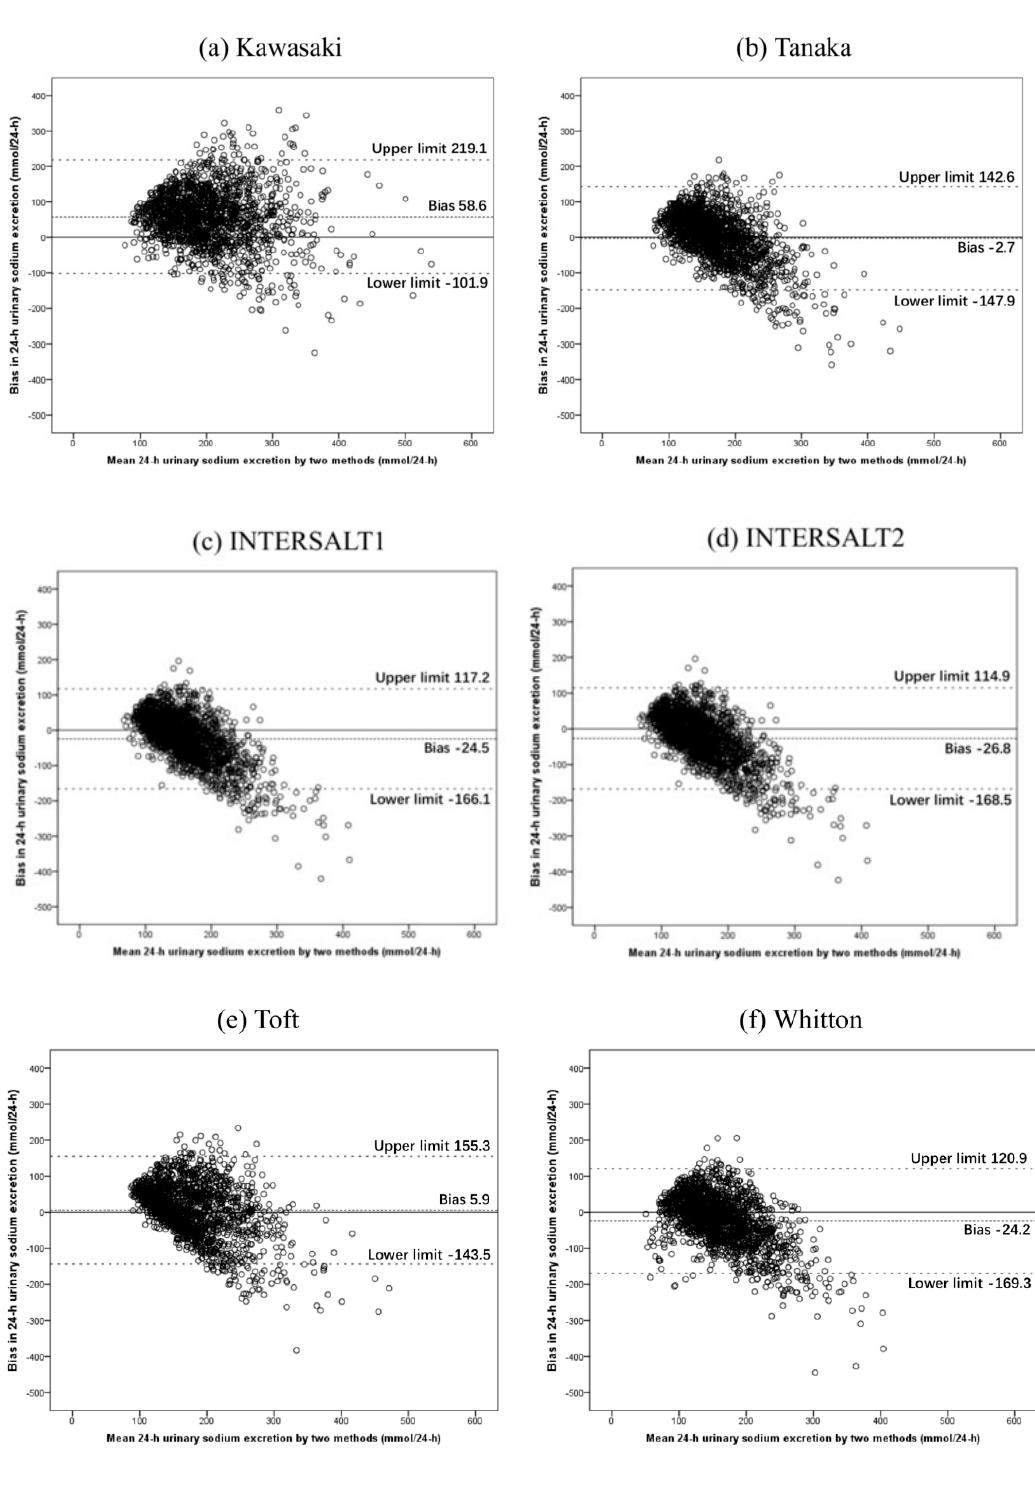
Figure 1. Bland–Altman plots comparing measured vs. estimated 24-hUNa excretion. ( a ) Kawasaki; ( b ) Tanaka; ( c ) INTERSALT1; ( d ) INTERSALT2; ( e ) Toft; ( f ) Whitton. The mid-dashed line was the mean bias. The dash-point line were 95% limits of agreement calculated by mean bias ± 1.96 standard